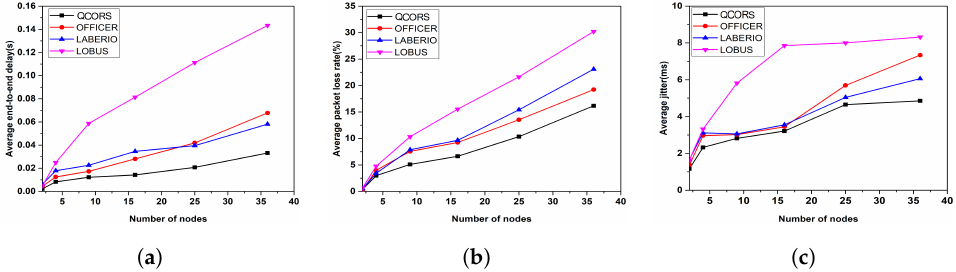
Figure 6. Performance comparison w.r.t. different strategies. The black line is our proposed approach. ( a ) Average delay comparison. ( b ) Packet loss comparison. ( c ) Average jitter